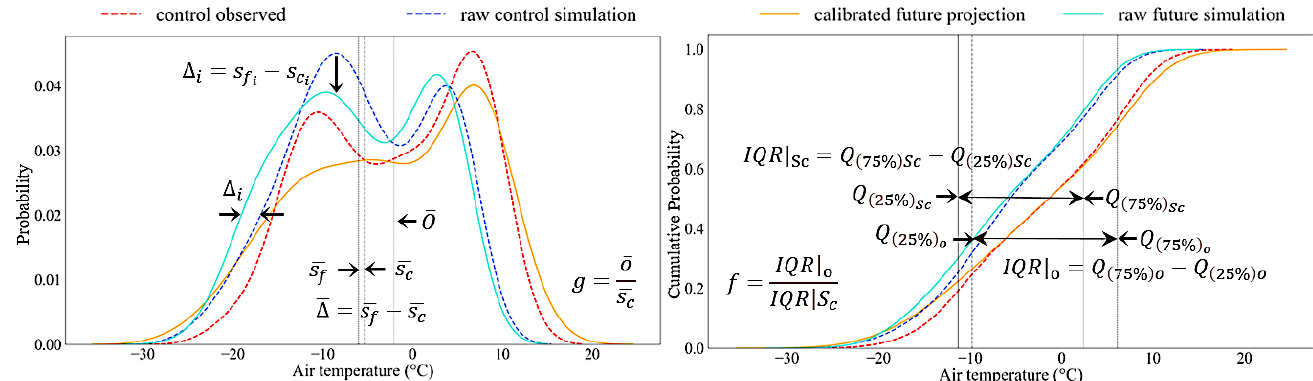
Figure 2. Illustrations of the variables involved in the quantile – quantile (Q-Q) adjustment approach with an example of air temperature on the Naqu site, with the control period being 1970 – 1984 and projection period being 1985 – 1999. Left shows the probability density functions (PDF) and the right, the cumulative density functions (CDF). The notations used are consistent with those in Equations (1) – (6). The lines of calibrated future projection represent the results after the adjustment. The vertical straight lines in the PDF subplot represent the means of the observations ( 𝑂̅ ) and raw simulations ( 𝑠 𝑐 ̅ ) in the control period and the mean of the simulations in the projection period ( 𝑠 𝑓 ̅ ). The percentile pairs used are the 25th and 75th and their corresponding values are described by 𝑄 (25%) and 𝑄 (75%) in the CDF subplot. Raw control simulation and raw future simulation data are from the GCM simulations; control observed data are the site observations or the calibrated results produced in the preceding adjustment; and calibrated future projection data are the results desired. The illustrative plot is created by the authors with reference to the concept of Yang et al. [78]